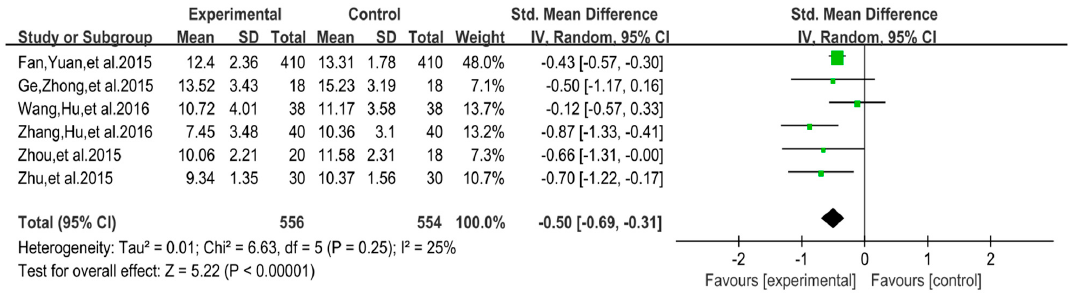
Figure 11. E ff ect of exercises on mood change. Figure 11. Effect of exercises on mood change.